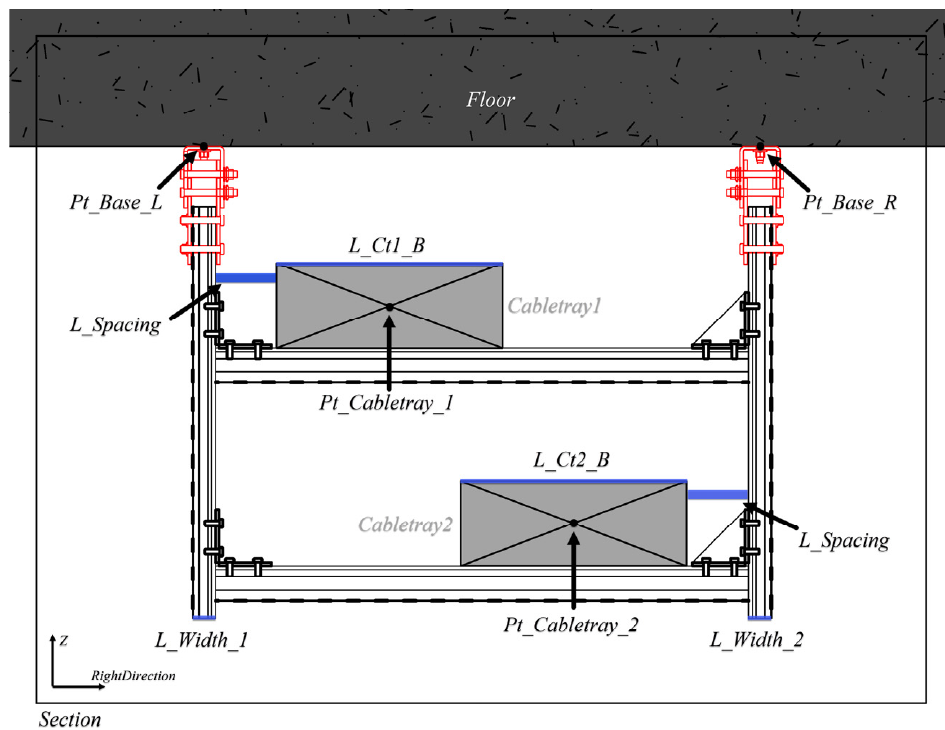
Figure 7. Schematic diagram of the calculation process of coordinates of the bases.